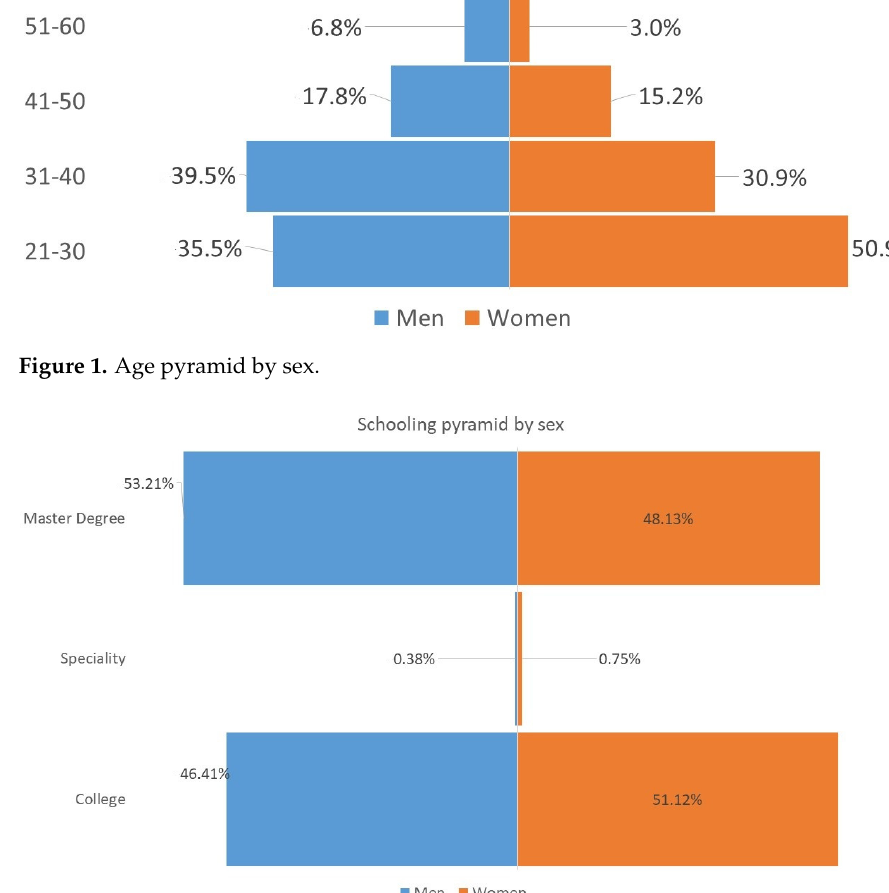
Figure 2. Schooling pyramid, by sex.